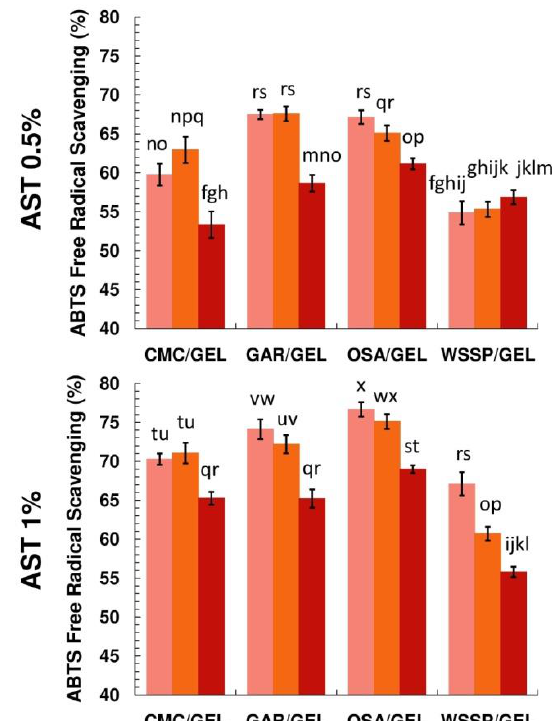
Figure 3. Effect of storage (25 ◦ C, 50% relative humidity) on the antiradical activity of AstaSana astaxanthin (AST)-free (A) and AST-supplemented films obtained from the 75/25 blends of polysaccharides (carboxymethyl cellulose (CMC), gum Arabic (GAR), octenyl succinic anhydride starch (OSA), water-soluble soy polysaccharides (WSSP)) and gelatin (GEL). a–x Values with the different superscript letters within one column are significantly different ( p >